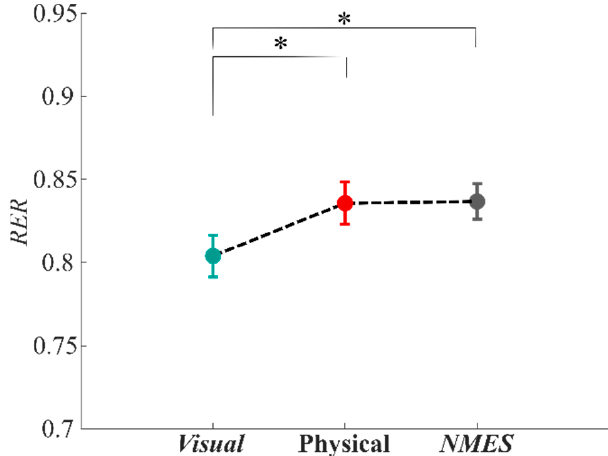
Figure 6. Metabolic cost result: the Respiratory Exchange Ratio ( RER ) parameter. Results are reported as mean and standard error values for the three feedback conditions ( Visual , Physical , and NMES ). Significant differences ( p < 0.0025) are marked with an asterisk.